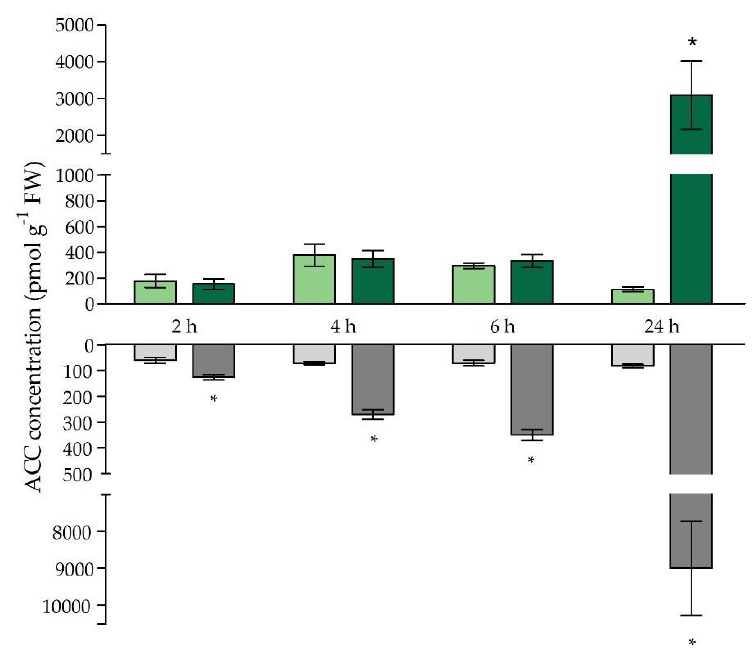
Figure 4. Free 1-aminocyclopropane-1-carboxylic acid (ACC) concentrations (pmol g − 1 fresh weight) in leaves (green bars) and roots (grey bars) of Arabidopsis thaliana plants grown under control conditions (0 µ M CdSO 4 , light bars) or exposed to 5 µ M CdSO 4 (dark bars) during 2 h, 4 h, 6 h and 24 h after 3 weeks of growth. For each time point, data represent the mean ± S.E. of four biological independent replicates. Significant di ff erences ( t -test: p < 0.05) between control and exposed plants, within each time point, are indicated with an asterisk (*).